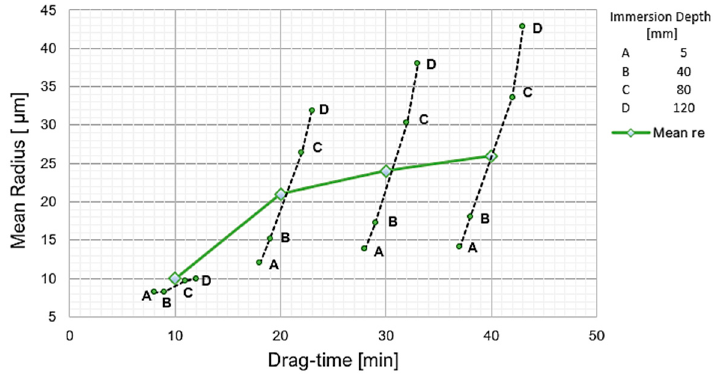
Figure 8. Combined effect of the drag time DT and the drag depth ID on the cutting edge radius r e .